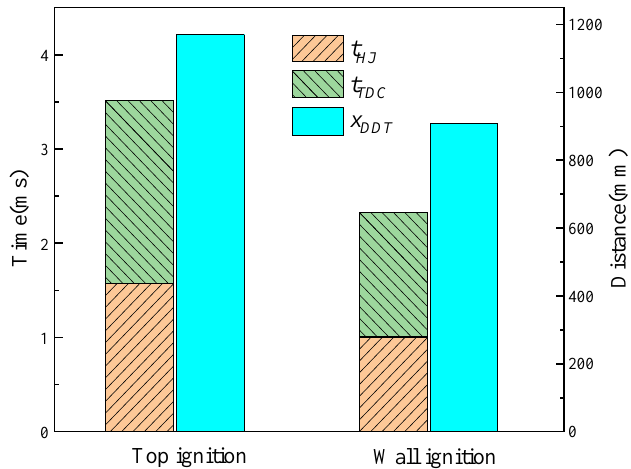
Figure 10. Time and distance to detonation initiation of top and wall ignition.